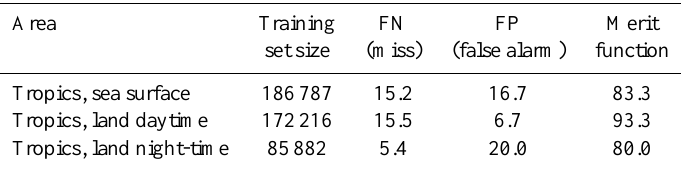
Table 7. Validation results using data sets IASI1 and IASI2. The total score ( S ) or equivalently merit function, false alarms and miss are shown in percentage.